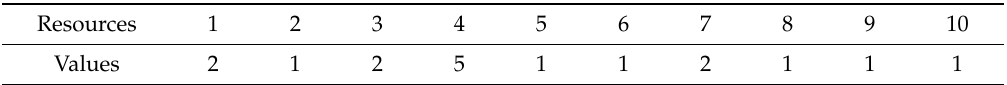
Table 1. Resources with their